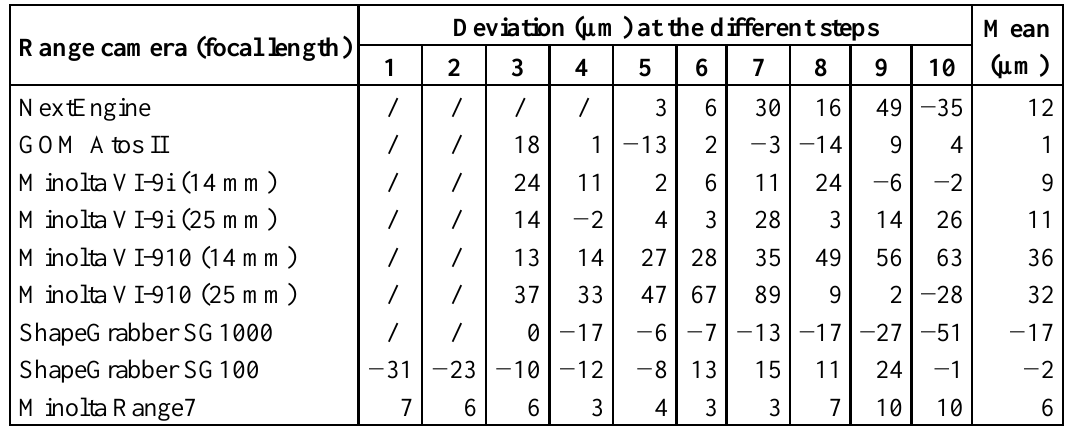
Table 7. Step-to-reference distance deviation. RMS distance between the plane located at the distance from the bottom given by the CMM measurement and the corresponding set of data originated by the range camera. Some of the cells in the table have not been filled due to the undistinguishbility between adjacent sets of data according to the definition given in section 6.2. Step 1 is the smaller (16